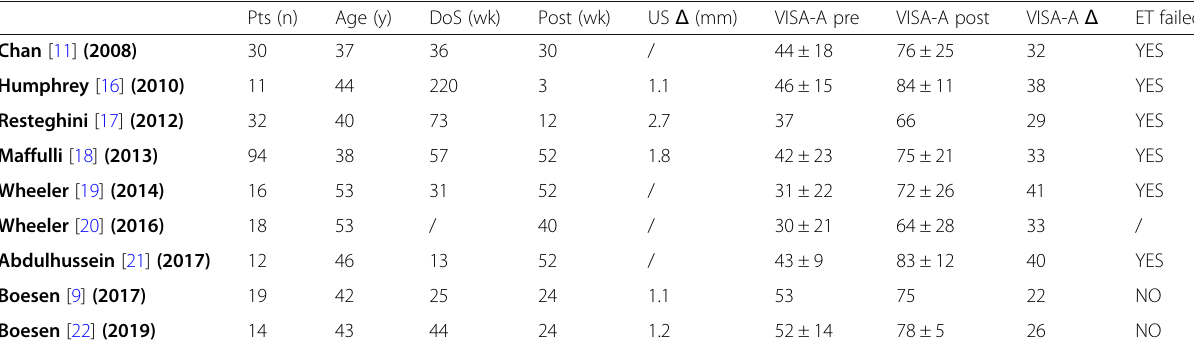
Table 3 Studies presenting data on High-volume Image-guided Injection